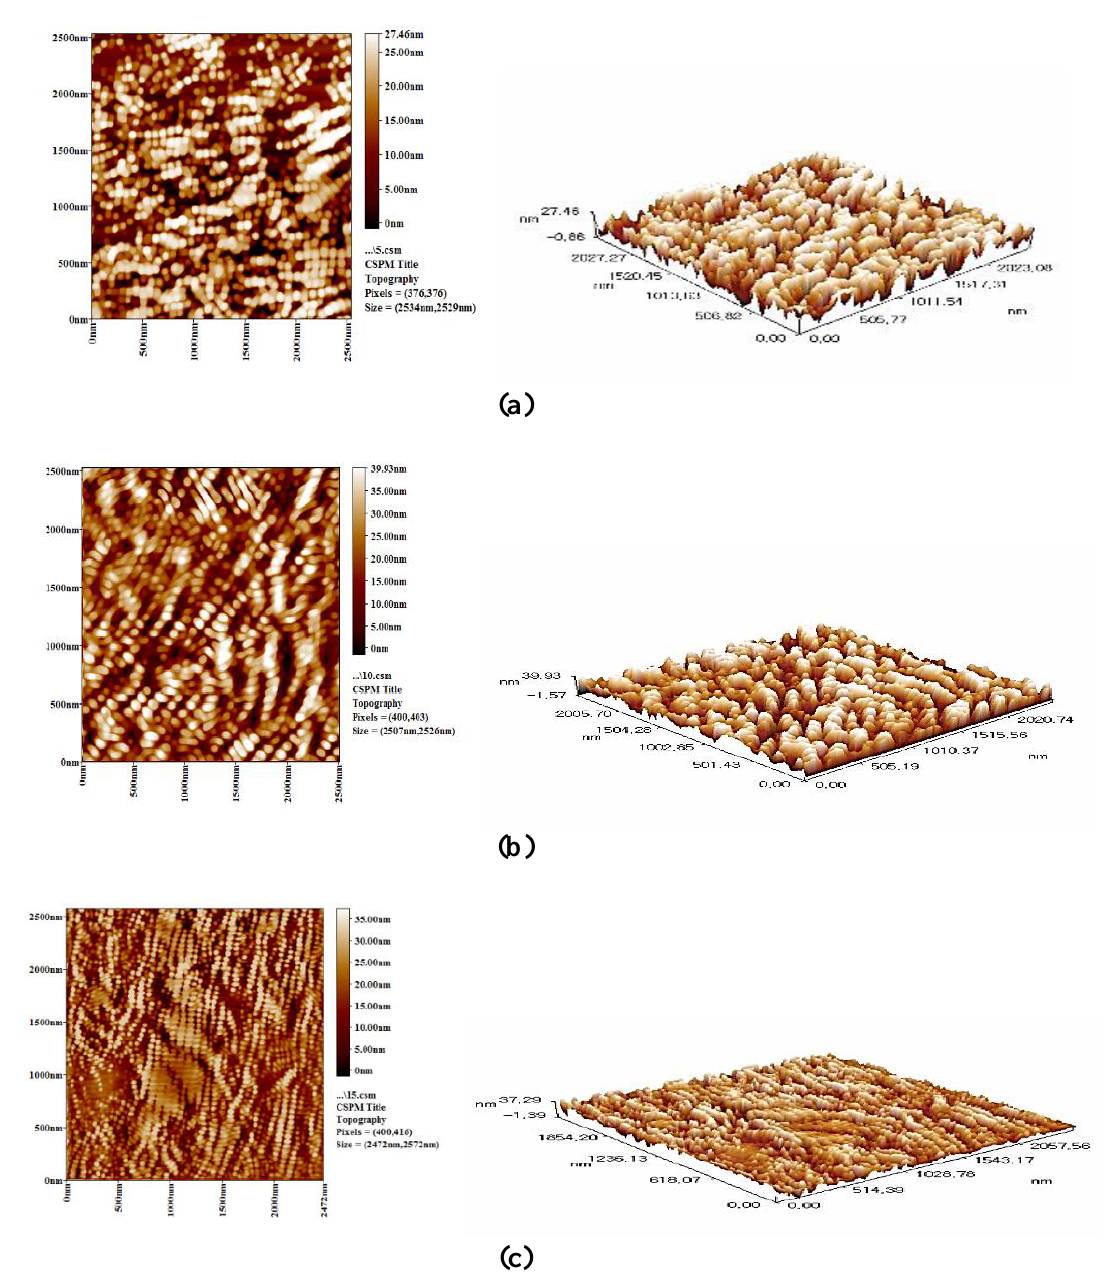
Figure 4: 2- and 3-D AFM images of porous quaternary Al on Si (111) substrates with different etching times of: a- 5 min, b- 10 min, and c- 15